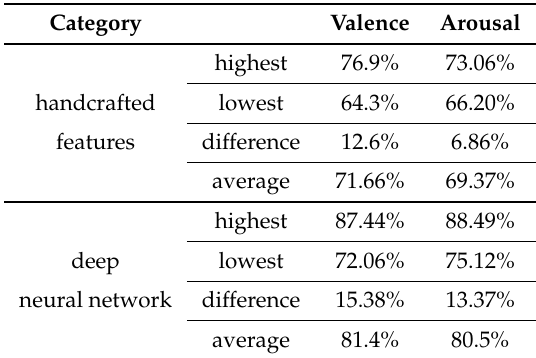
Table 5. Summary of the